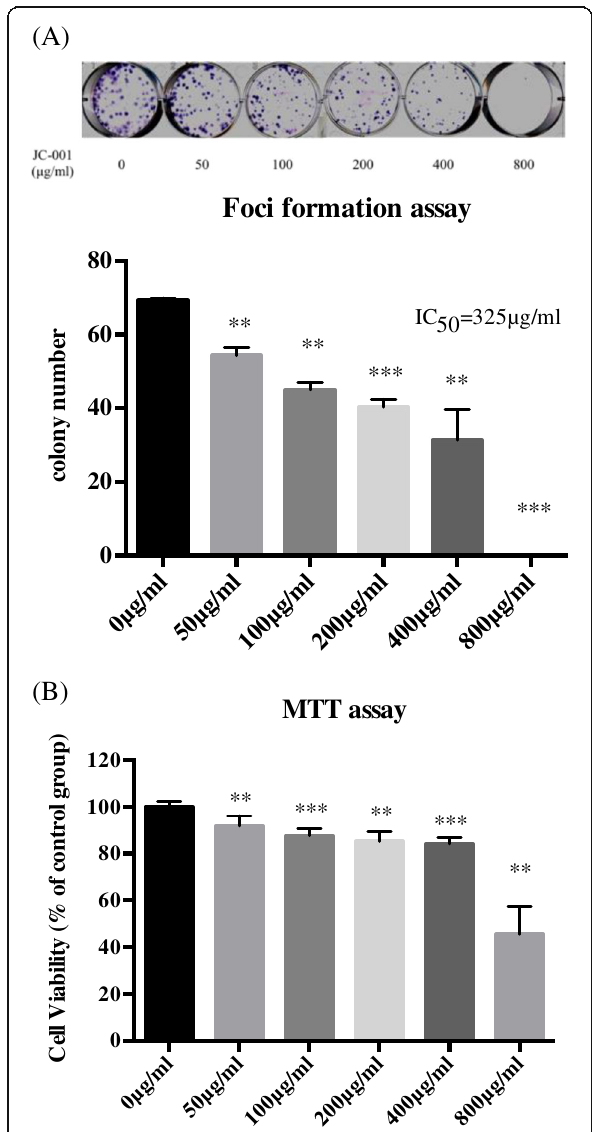
Fig. 1 JC-001 affects the foci formation activity and cell viability of LLC1 cells in vitro. a The IC 50 of JC-001 for the inhibition of foci formation by LLC1 was 325 μ g/mL. b The effect of JC-001 on the cell viability of LLC1. * p < 0.05, ** p < 0.01, *** p < 0.001 compared with the control group. The results are expressed as mean ± SD of three separate